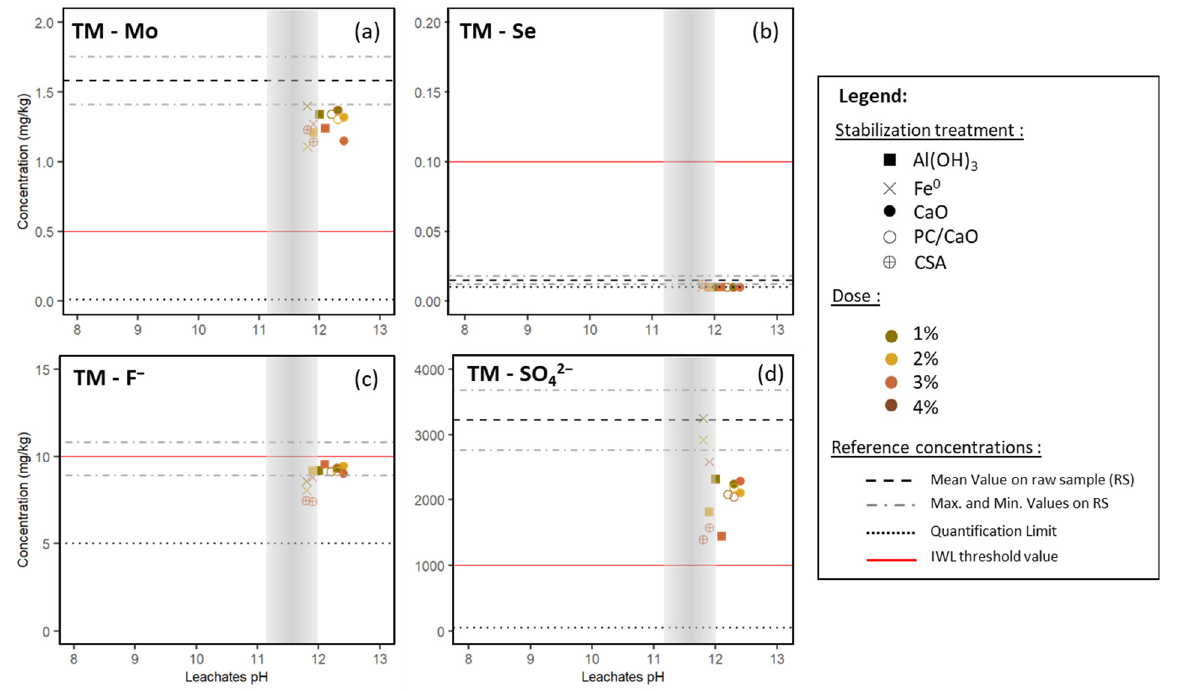
Figure 4. Mo ( a ), Se ( b ), fluorides ( c ) and sulfates ( d ) concentrations in the leachates of standardized